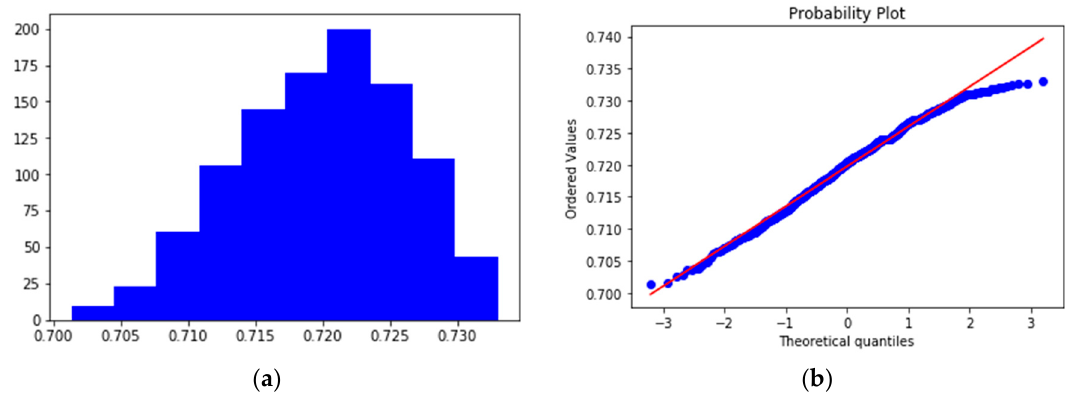
Figure 3. Uncertainly analysis at 90 days of leaching, copper recovery distribution ( a ) and normal probability plot ( b ).